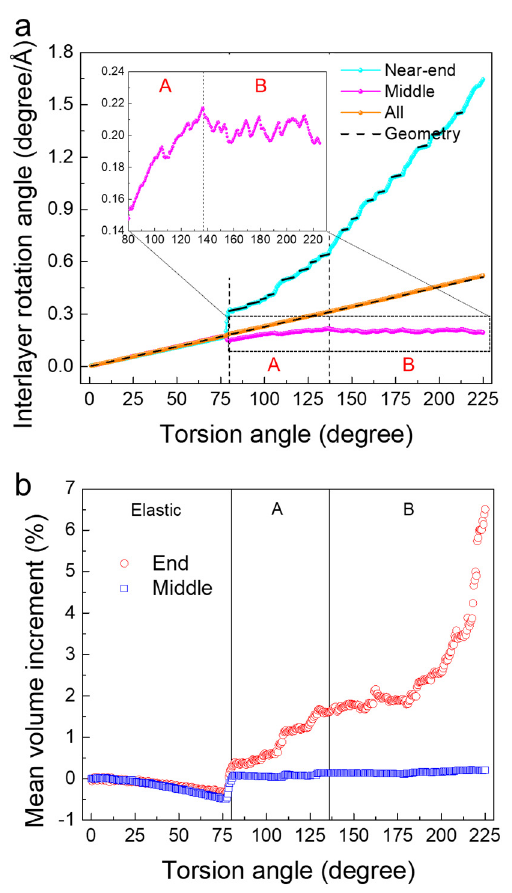
Figure 3. ( a ) Interlayer rotation as functions of torsion angle in the end (cyan), middle (magenta), and the entire sample (orange). The black dashed line indicates the geometrical expectation. ( b ) Mean atomic volume increment as functions of the torsion angle in the end (red) and middle (blue) part.